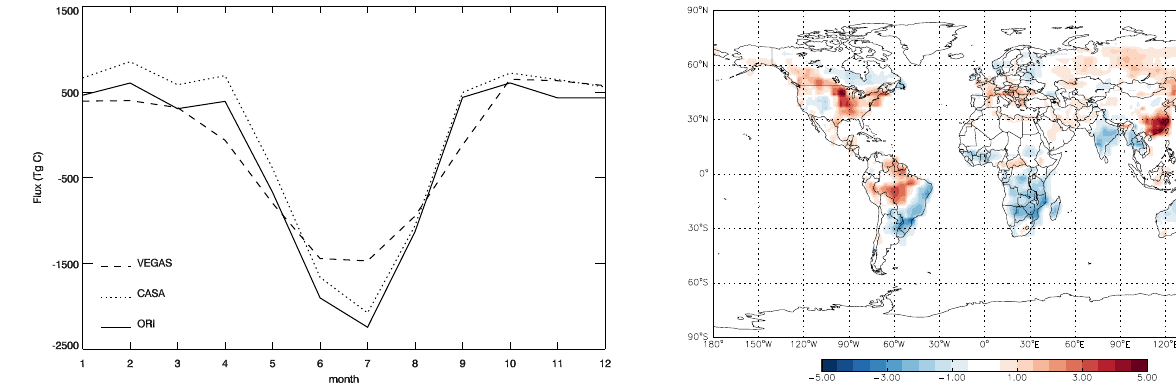
Fig. 1. Monthly terrestrial fluxes from dynamic global vegetation Fig.1. Monthly terrestrial fluxes from dynamic global vegetation models (CASA and models (CASA and VEGAS) and original land–atmosphere fluxes VEGAS) and original land-atmosphere fluxes (ORI, including fluxes from CASA, (ORI, including fluxes from CASA, biofuel burning, biomass burn- ing and residual annual biospheric flux) in GEOS-Chem in 2006. biofuel burning, biomass burning and residual annual biospheric flux ) in GEOS-Chem in 2006.